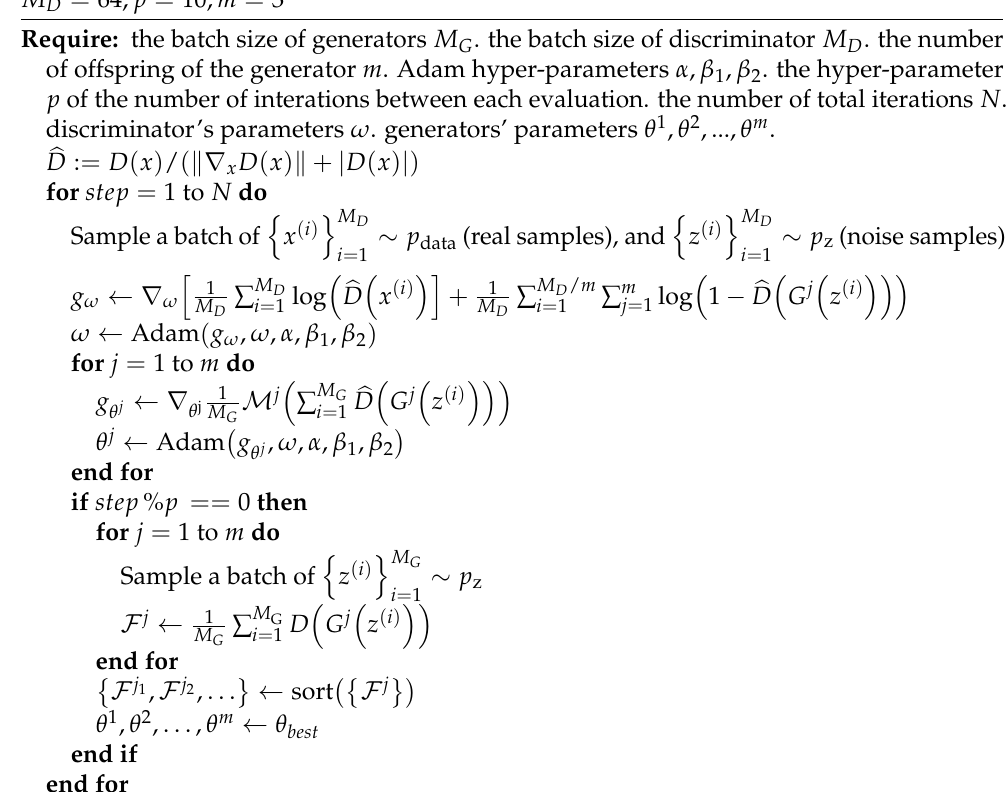
Algorithm 1 PEGANs. Default Values: α = 0.0002, β 1 = 0, β 2 = 0.9, M G = 128,